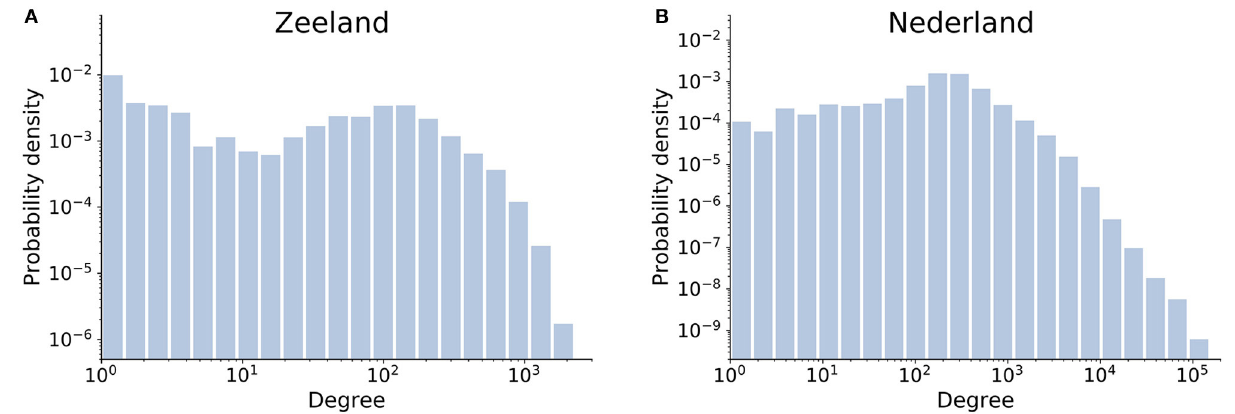
TABLE 2 | Description of the data provided by CBS. Nodes Layers Multi-edges Simple edges Nodes Multi-edges Simple edges